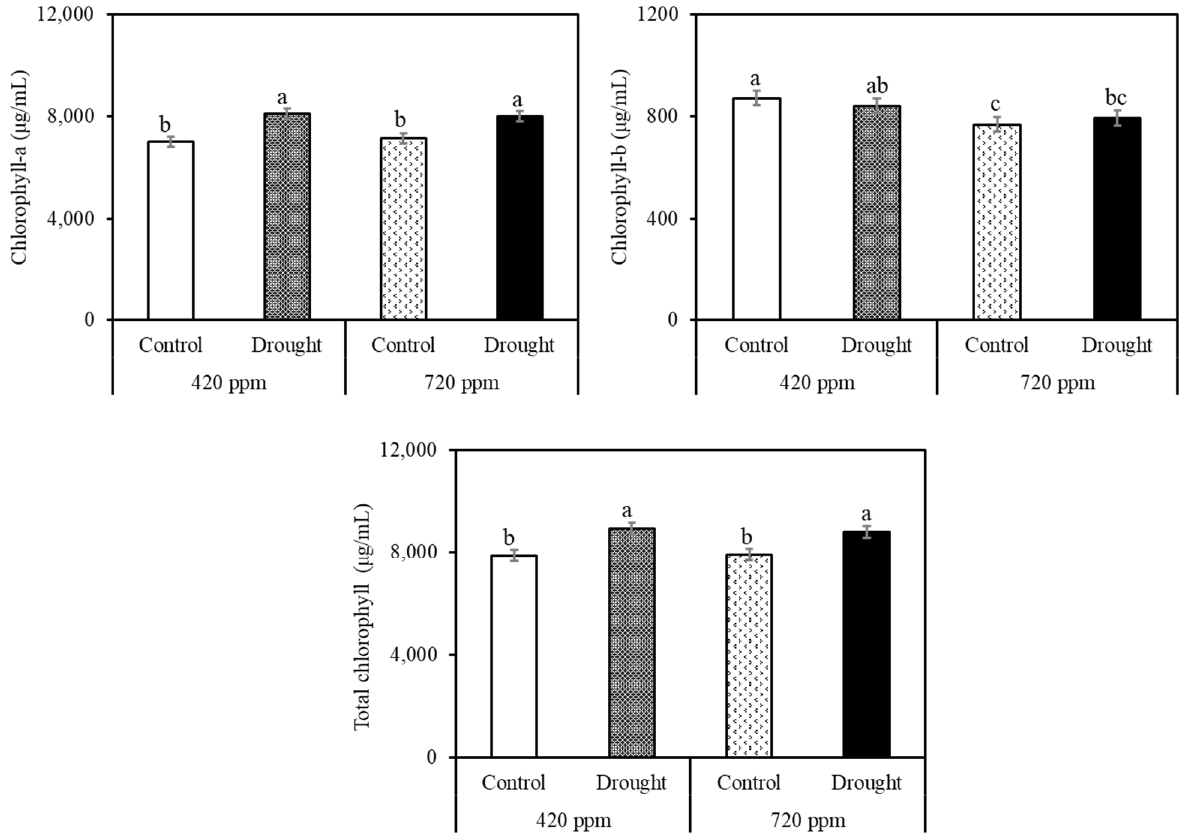
Figure 3. Chlorophyll-a (Chla), Chlorophyll-b (Chlb), and Total chlorophyll (TChl) estimation of basil plants grown without drought stress (control) and with drought stress at two levels of CO 2 (420 and 720 ppm) after 17 days of treatment. Data are presented as treatment means ± SE ( n = 10). Different low case letters indicate a significant difference at p < 0.05 by the least significant difference.